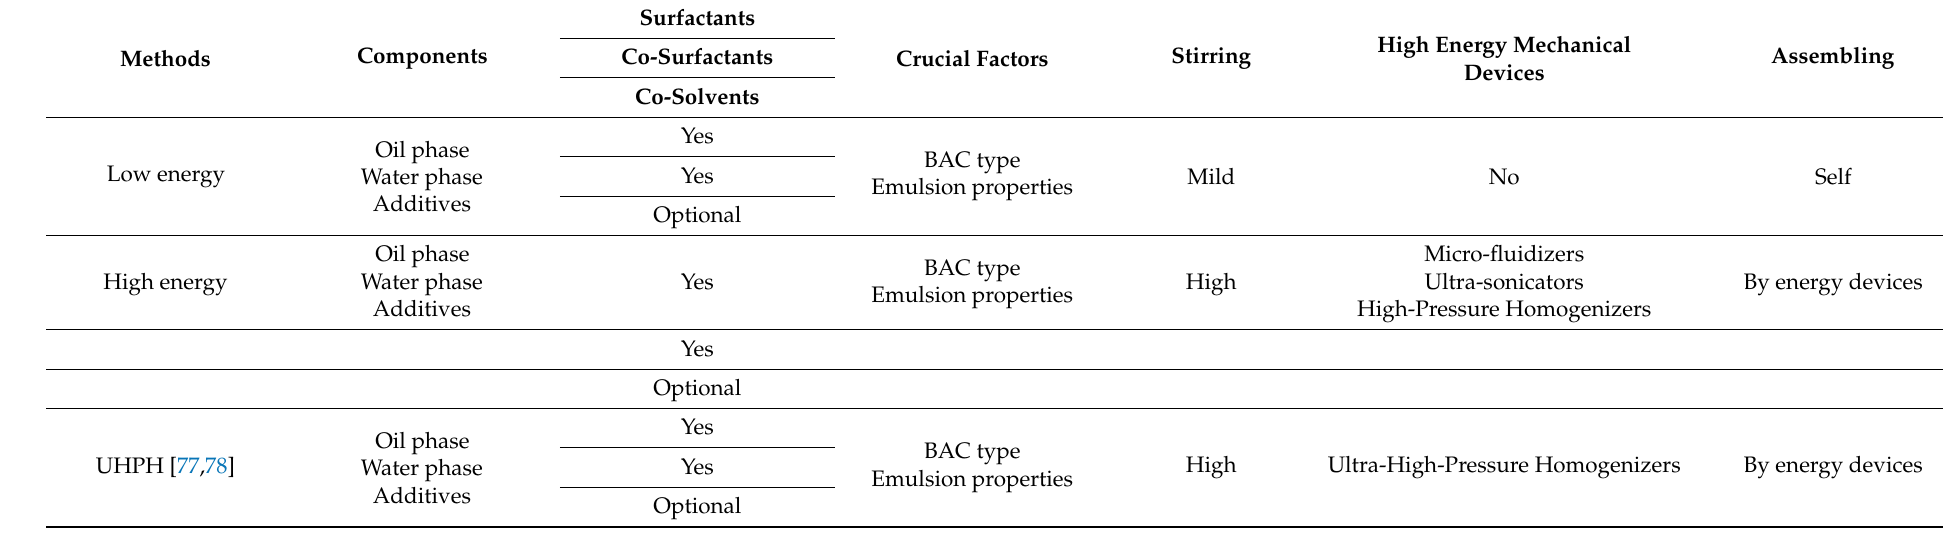
Table 5. Some common methods for NEs